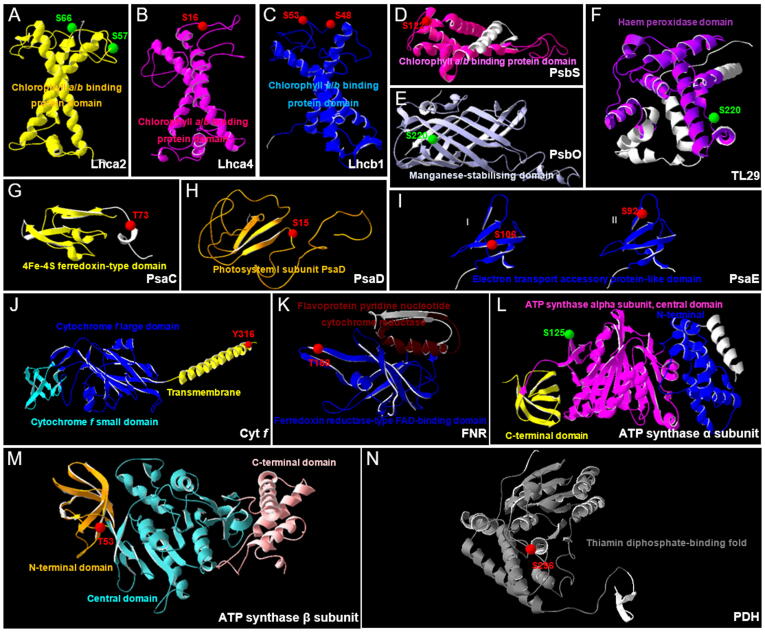
A list of MS/MS spectra of phosphopeptides derived from alkaligrass chloroplast phosphoproteins